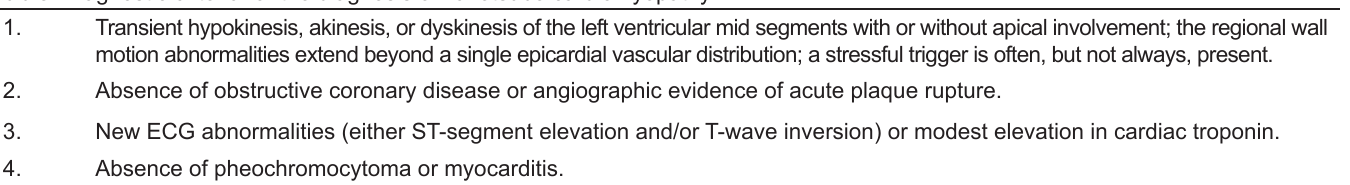
Table. Diagnostic criteria for the diagnosis of Takotsubo cardiomyopathy. 5